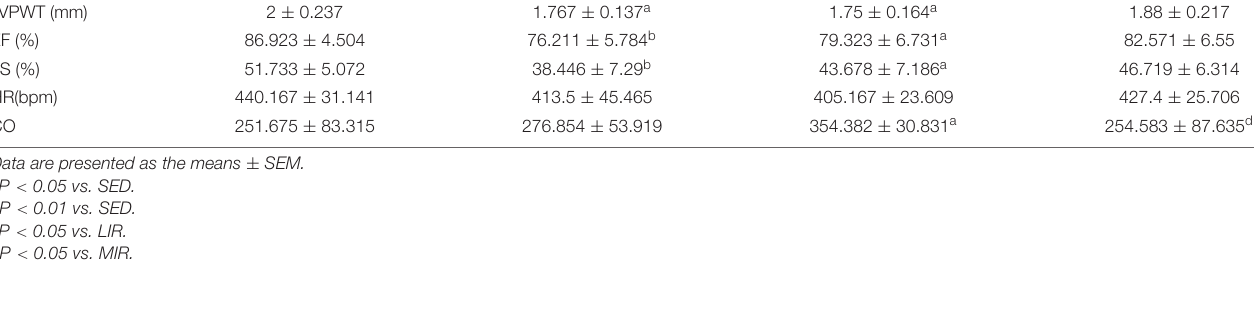
TABLE 3 | Echocardiographic analysis of SD rats subjected to different treadmill running intensities after 4 weeks. Criteria